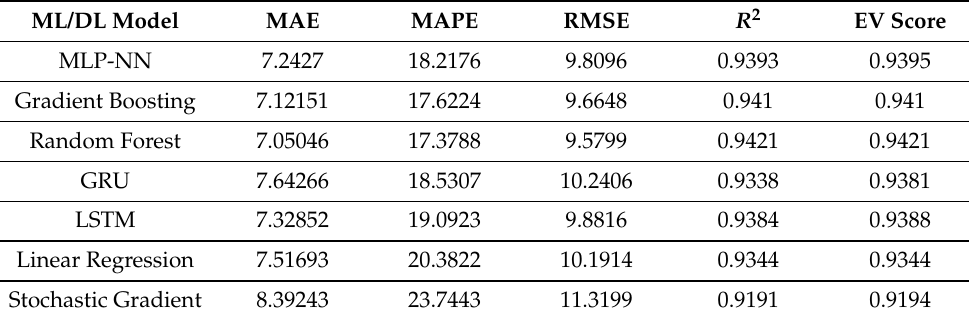
Table 2. Performance metrics using the second dataset (PeMS) [25].